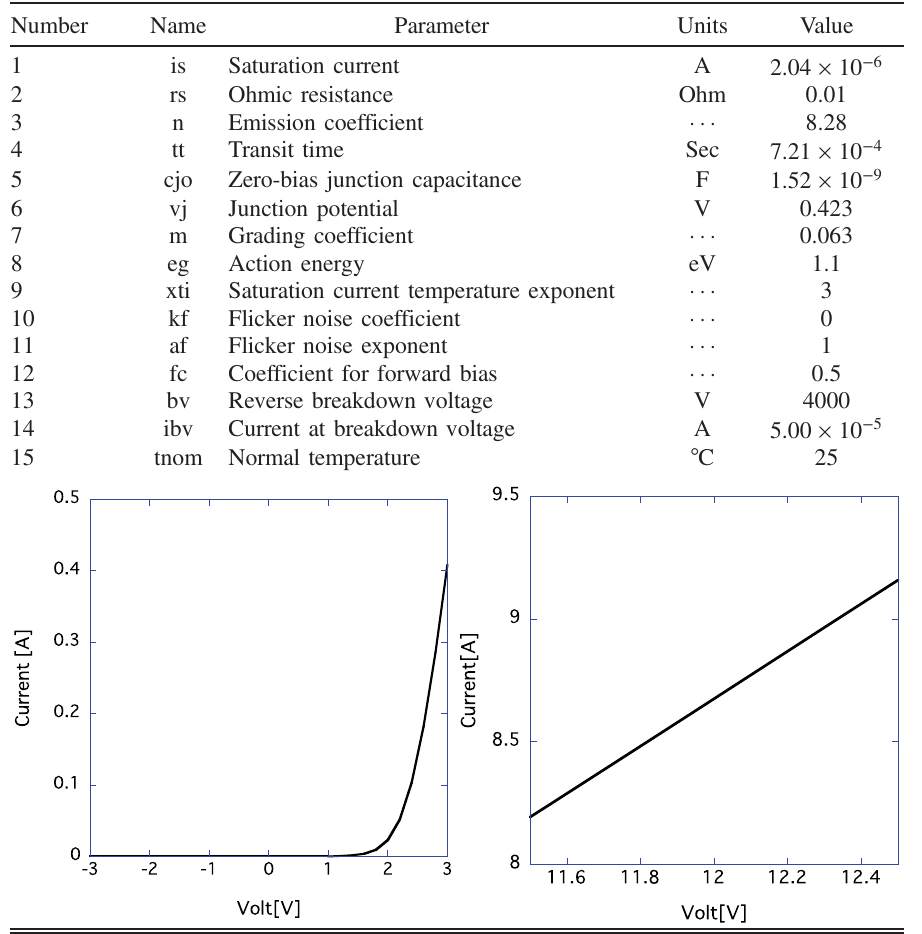
TABLE I. SPICE parameters for one module, whose V-I curve (left) from − 3 to 3 V and that (right) from 11.5 to 12.5 V are represented in the bottom figures. One diode shown in Fig. 5 consists of four parallel branches, each branch contains thirteen modules in